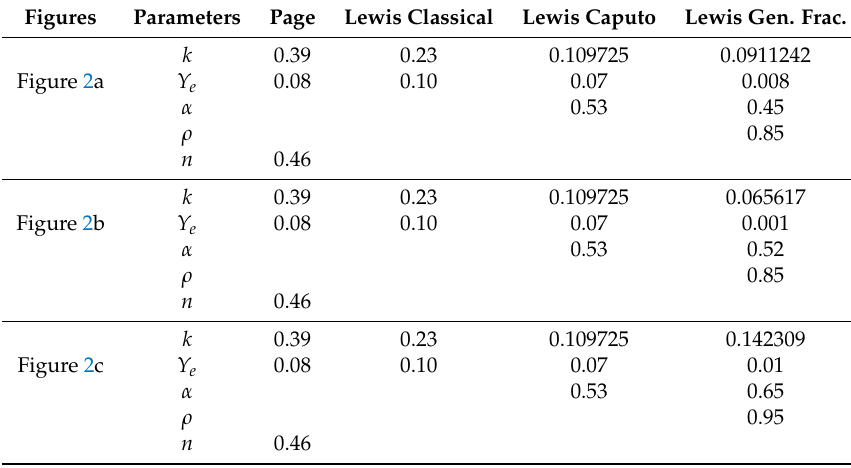
Table 2. Parameter values of models